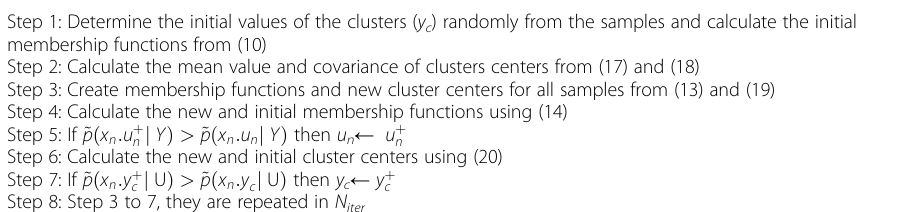
Algorithm-II : Task discrimination (Bayesian Fuzzy